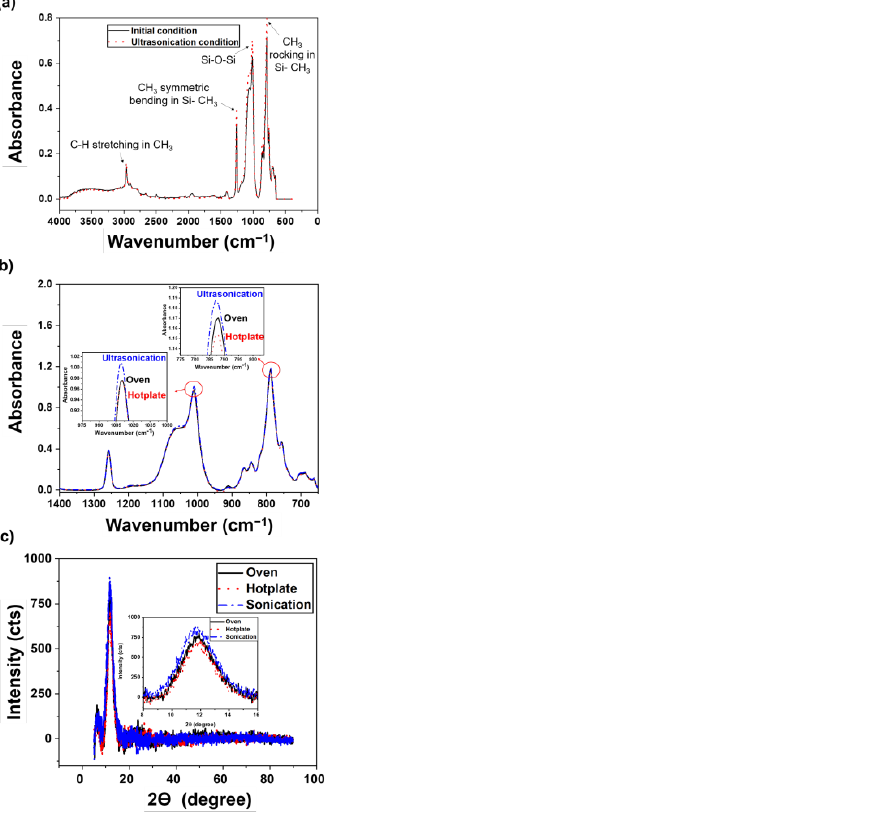
Figure 3. Molecular spectroscopy analysis. ( a ) ATR spectra of the PDMS base solution with and without ultrasonic treatment, ( b ) FT-IR spectra, and ( c ) XRD pattern of the PDMS thin films under different curing methods.